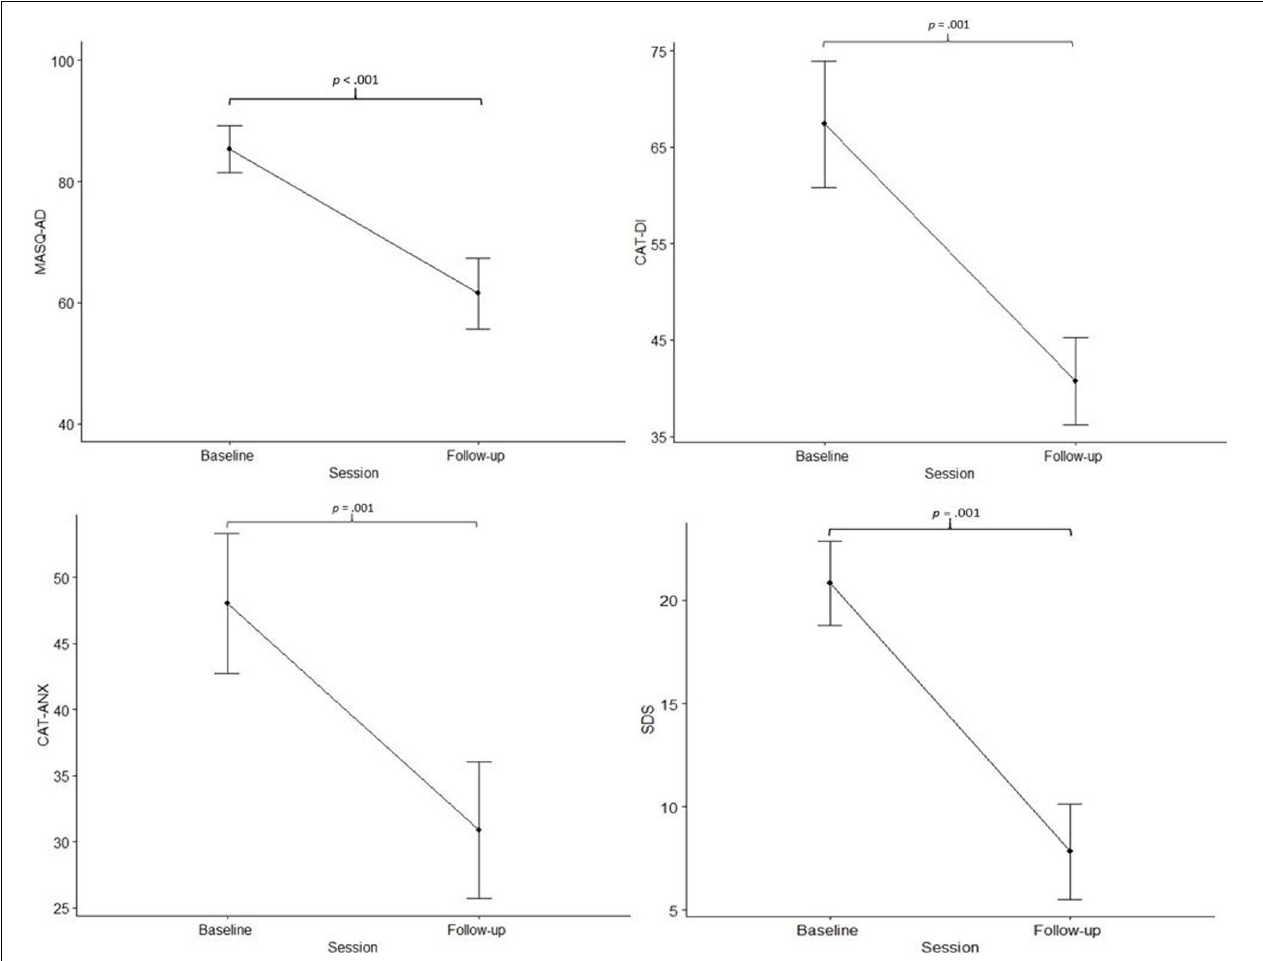
FIGURE 1 | Measures of anhedonia, depression, and anxiety. Mean scores of item responses on the MASQ-AD, Mood and Anxiety Symptom Questionnaire-Anhedonic Depression; CAT-DI, Computerized Adaptive Testing-Depression; CAT-ANX, Computerized Adaptive Testing-Anxiety; and SDS, Sheehan Disability Scale; at baseline and 1-month follow-up. Error bars represent standard error of the